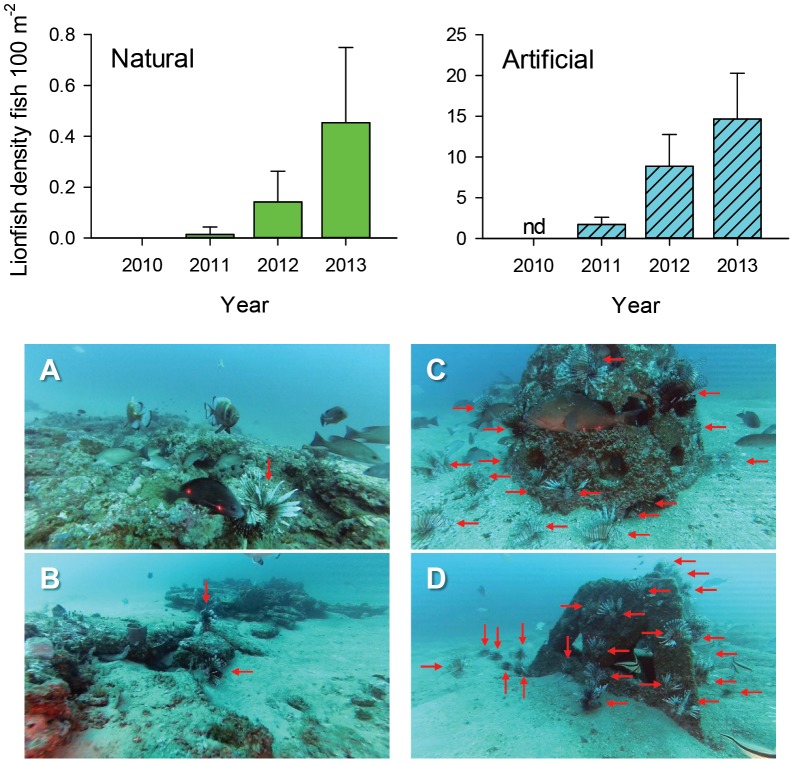
Mean densities of lionfish 100 m−2 on natural and artificial reefs.Mean (95% CI) density of lionfish in fall 2010−2013 estimated with micro remotely operated vehicle-based video sampling at northern Gulf of Mexico natural (A,B) and artificial reef sites (C,D); red arrows in reef images indicate lionfish. No video sampling occurred at artificial reef sites in fall 2010.